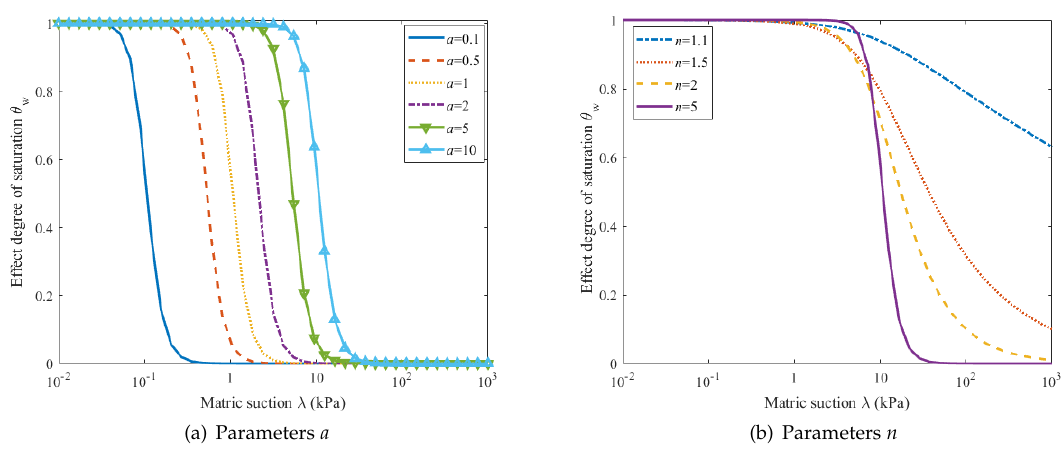
Figure 1. Analysis of the influence of parameters a and n on the SWCC equation. Figure 1. ( a ) The influence of parameters a on the soil–water characteristic curve (SWCC), and the n is 5 in this figure; ( b ) The influences of parameters n on the SWCC equation, and the a is 2 in this